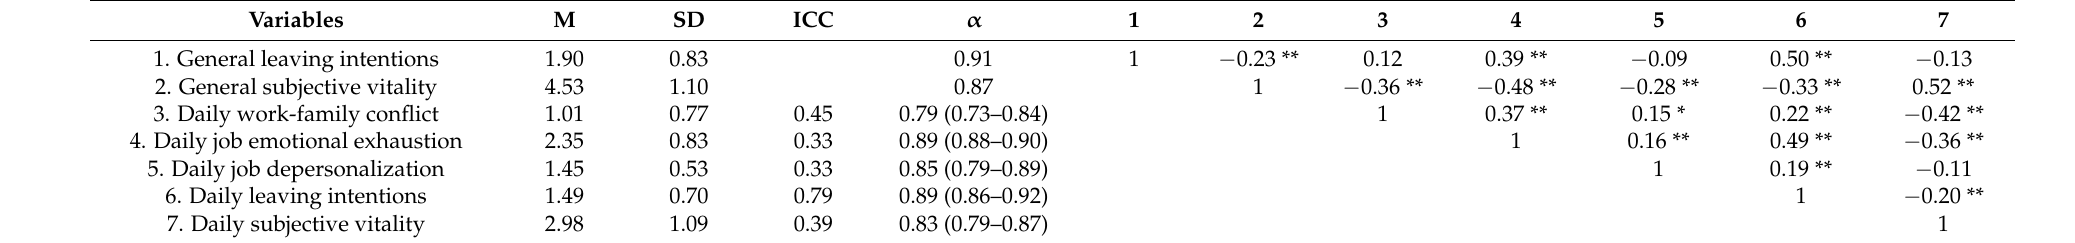
Table 1. Means, standard deviations, intra-class correlations, Cronbach’s alphas and correlations among variables.